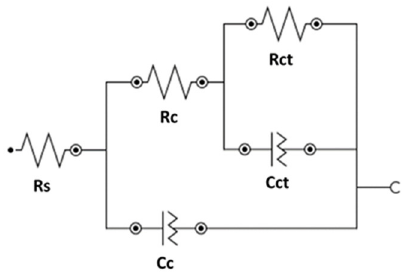
Figure 5. Equivalent circuit.